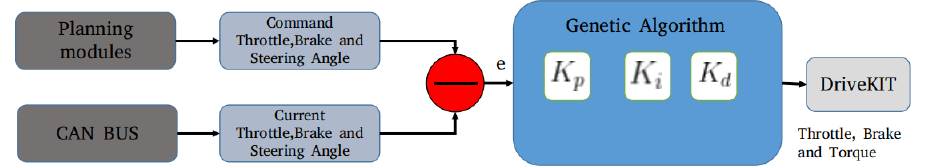
Figure 19. Framework for tuning the PID parameters using genetic algorithm is shown. The parameters are tuned for throttle, brake and steering